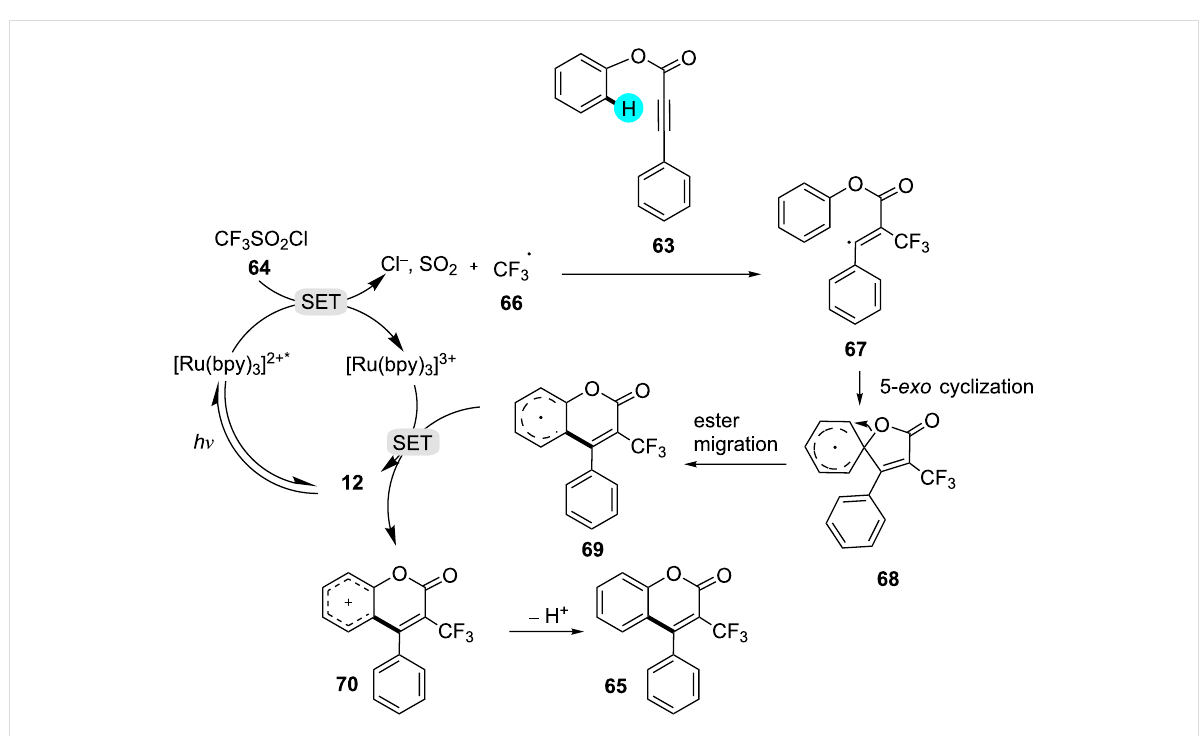
Figure 11: Mechanistic pathway for the synthesis of coumarin derivatives via C–H